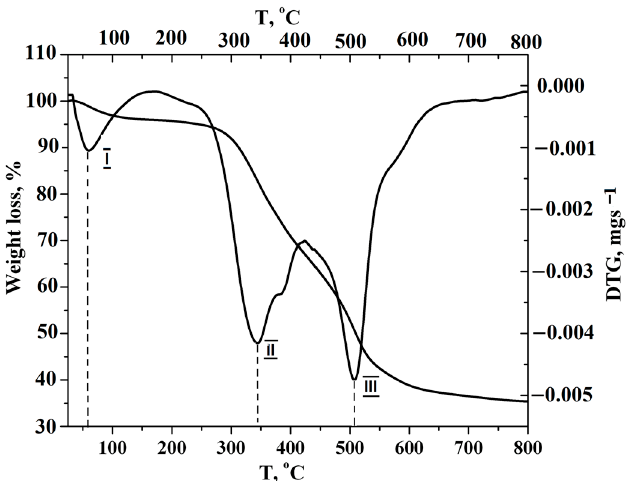
Figure 5. TG-DTG curves for polysulfone functionalized with triethylphosphonium groups. Table 2. Thermogravimetric data 1 for polysulfone functionalized with triethylphosphonium groups. Stage of